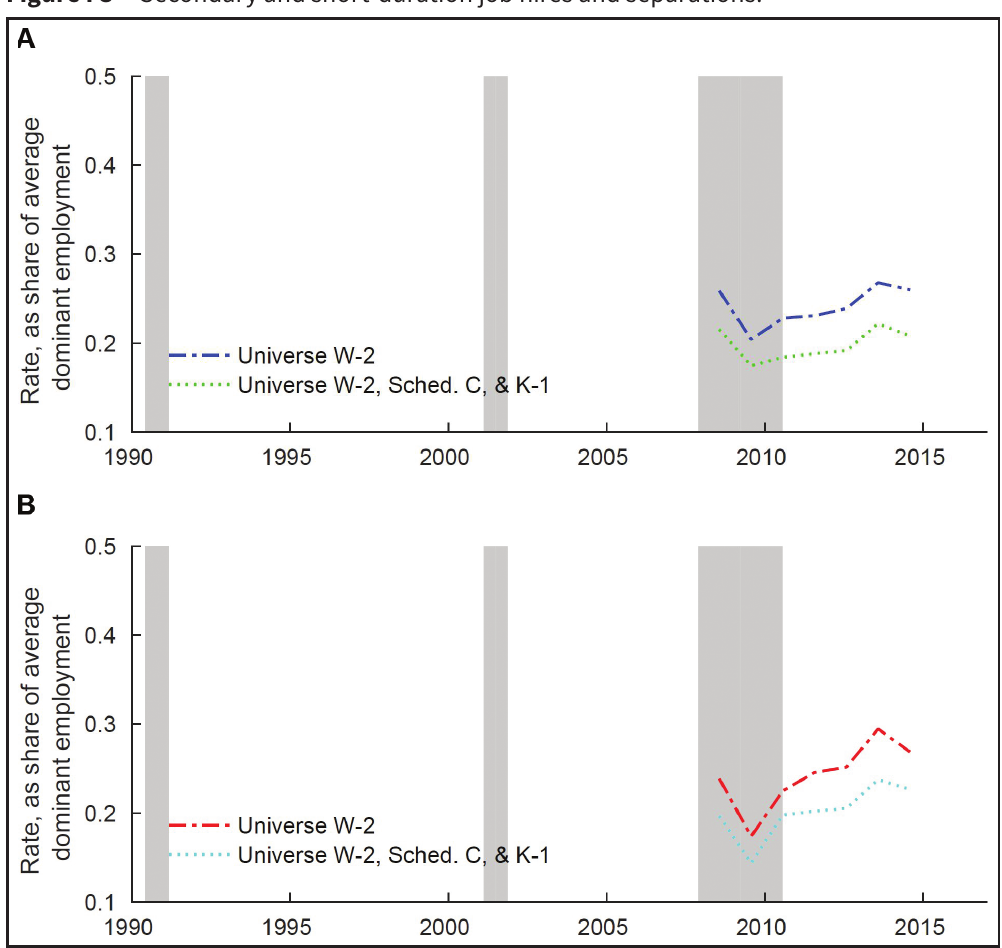
Secondary and short-duration job hires and